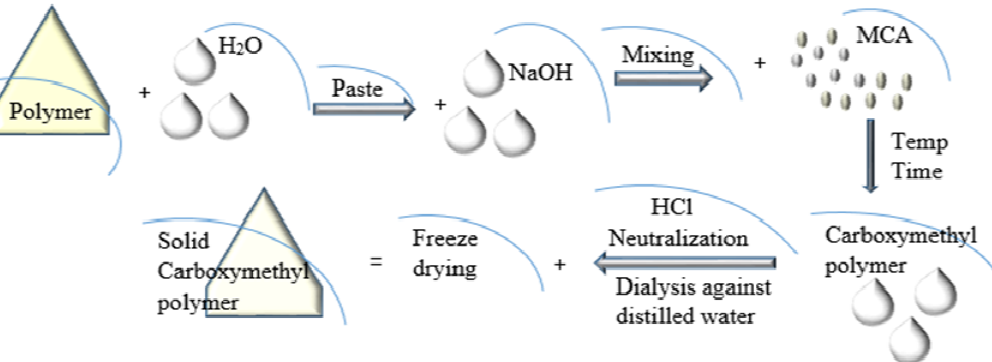
Figure 3. A simple process of carboxymethylation of a natural polymer. Adapted from